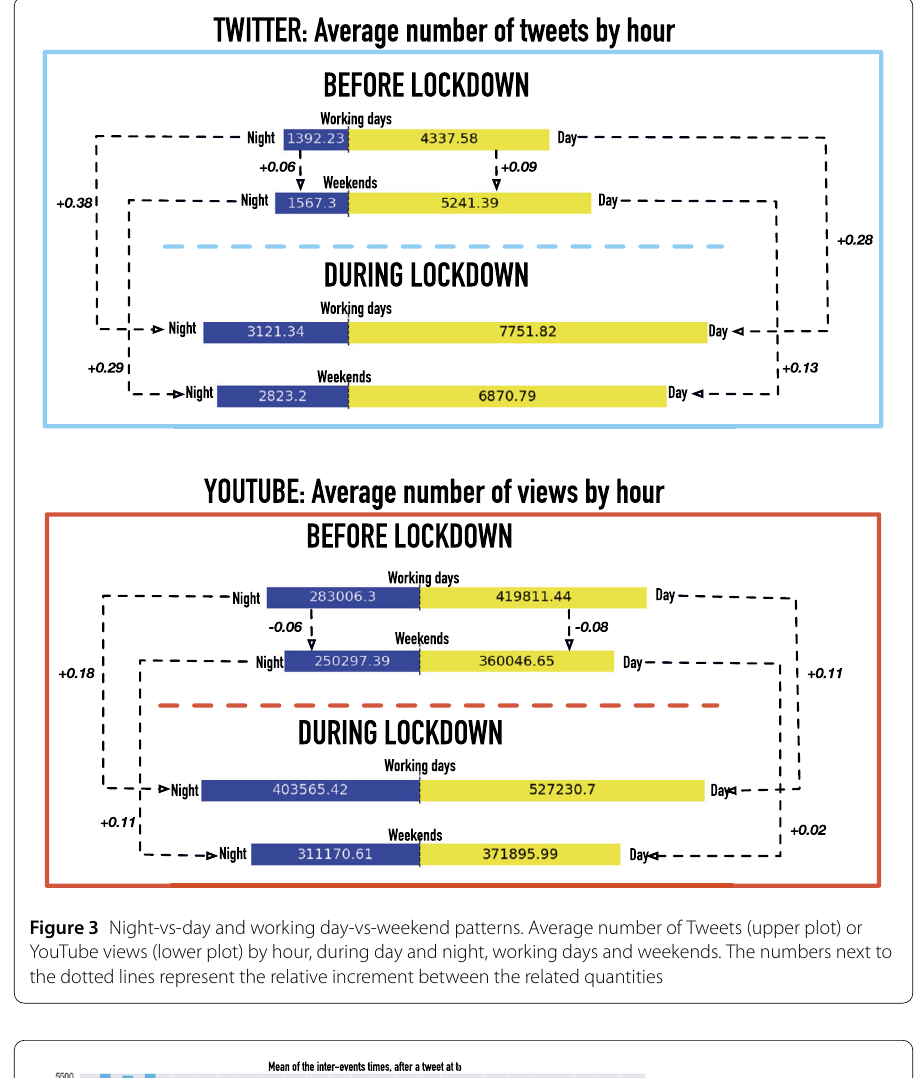
Figure 3 Night-vs-day and working day-vs-weekend patterns. Average number of Tweets (upper plot) or YouTube views (lower plot) by hour, during day and night, working days and weekends. The numbers next to the dotted lines represent the relative increment between the related quantities